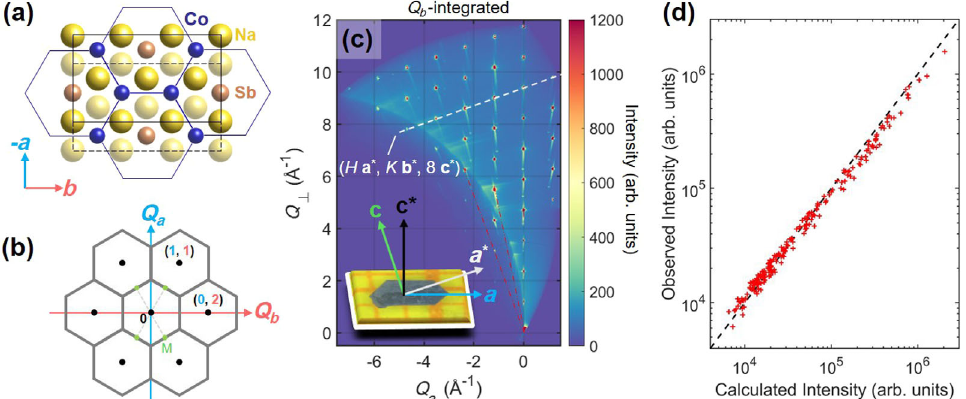
FIG. 1. (a) Unit cell of Na 3 Co 2 SbO 6 viewed from the top perpendicular to the ab plane, omitting oxygen atoms. The solid (dashed) rectangle indicates cell boundary in the top (bottom) Na layer. Hexagons indicate the Co sublattice in the middle layer. (b) Two- dimensional (2D) structural Brillouin zones, indexed in units of a (cid:3) and b (cid:3) projected into the ab plane. Zone centers ( Γ points) are þ Q ¼ even, and M points are midpoints between Γ . (c) X-ray diffraction in the a (cid:3) c (cid:3) plane, obtained on a twin-free crystal after Q a b integration along b (cid:3) . The data can be indexed in a monoclinic setting without twinning. Radial Bragg tails are due to energy spread of the monochromated x rays. The inset is a photo of a crystal with pertinent axes indicated. (d) Observed x-ray diffraction intensities from 204 indexed Bragg peaks compared to calculation from the ideal crystal